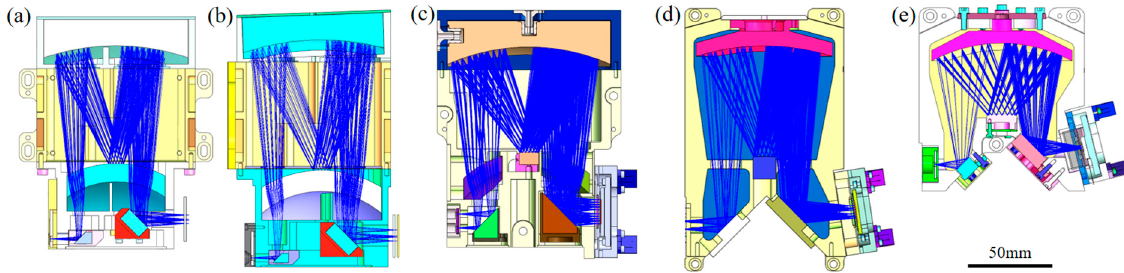
Figure 6. Profile map of spectrometers in GeoFWHIS. ( a – e ) from B1 band to B5 band. Table 4. System parameters and performance of spectrometers